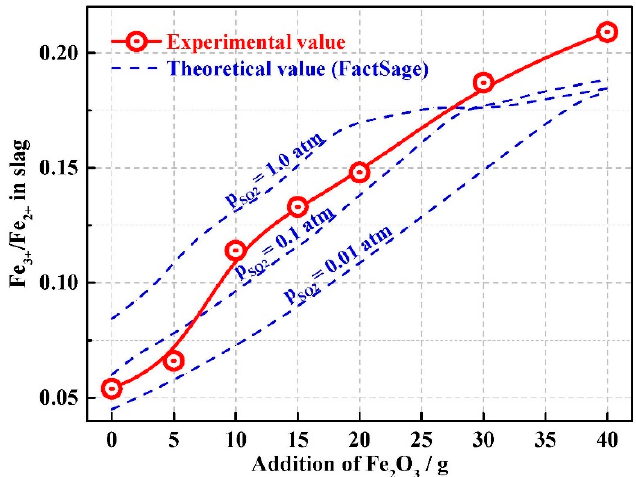
3 + / Fe 2 + ) with Fe 2 O 3